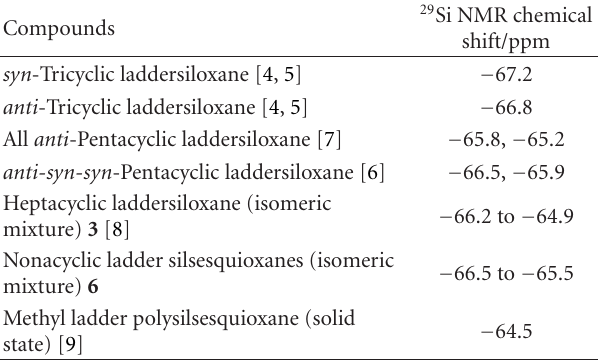
Table 1: 29 Si NMR chemical shift of laddersiloxanes.